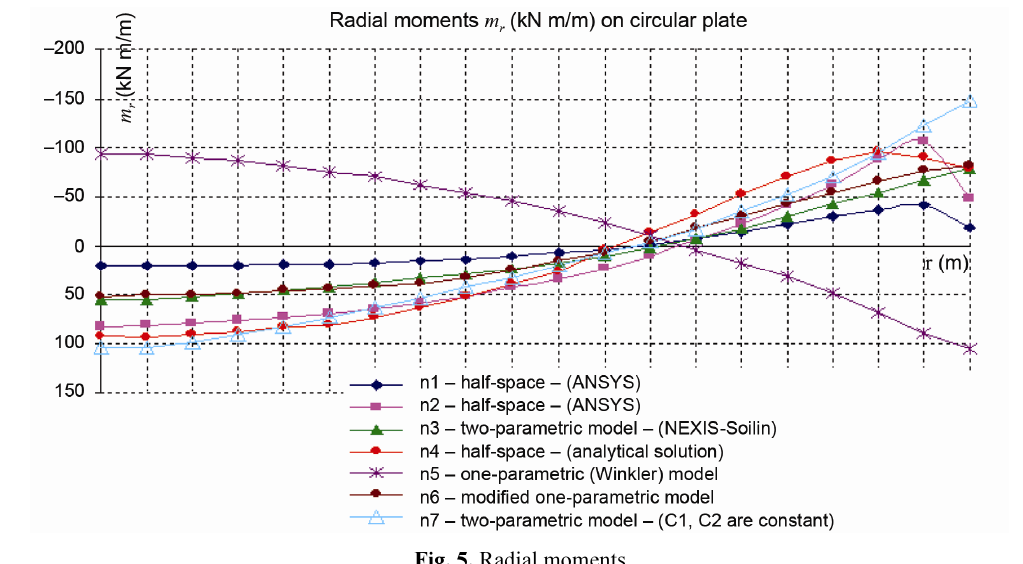
Fig. 5. Radial moments